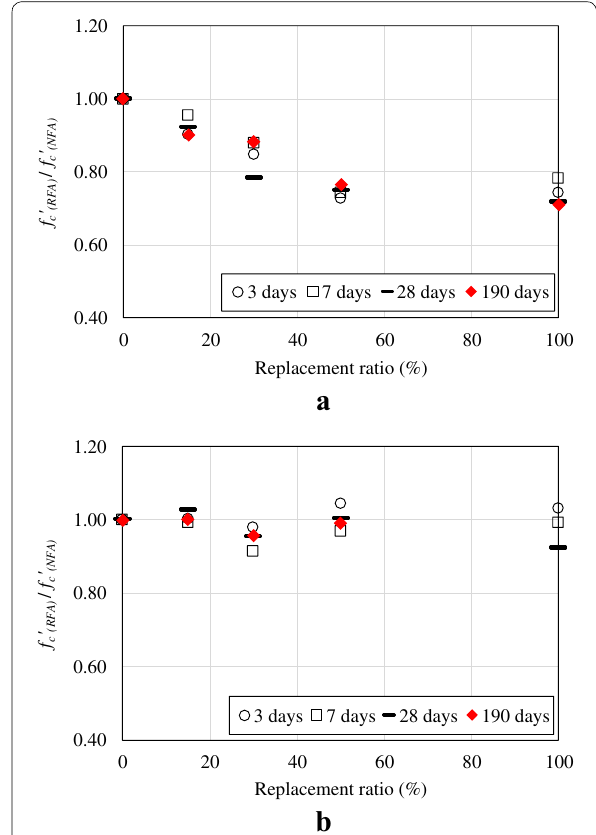
Fig. 2 Compressive strength reduction for ( a ) NS concrete, and ( b ) HS concrete at 28